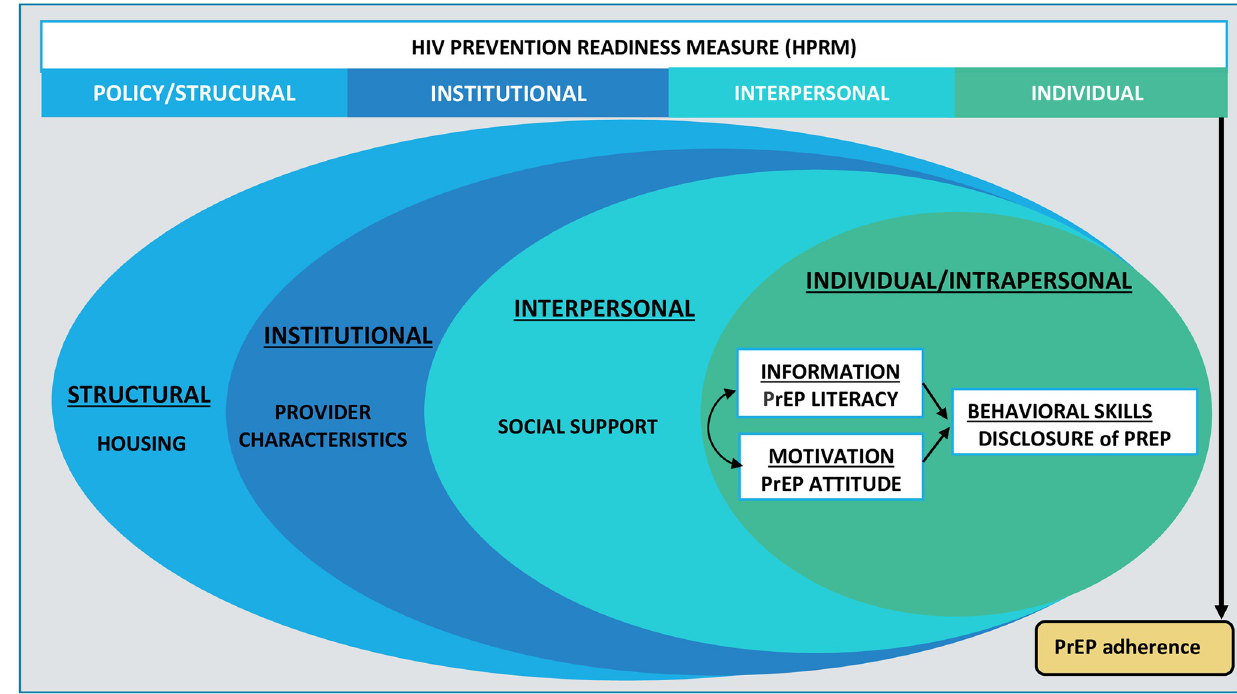
Fig 1. Mapping of HIV prevention readiness measure to situated-Information, Motivation and Behavioral framework (sIMB).